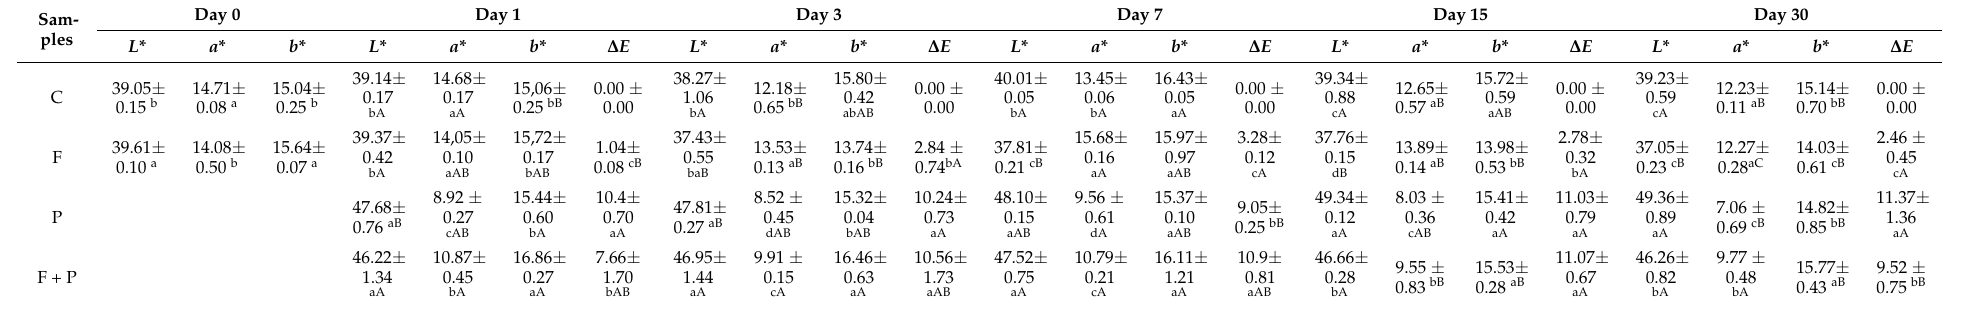
Table 2. CIE L *, a * and b * values of control, frozen and pressurized (350 MPa, 10 min, 10 ◦ C) after frozen and pressurized without frozen samples during the storage (F+ samples at − 21 ◦ C; other samples at +4 ◦